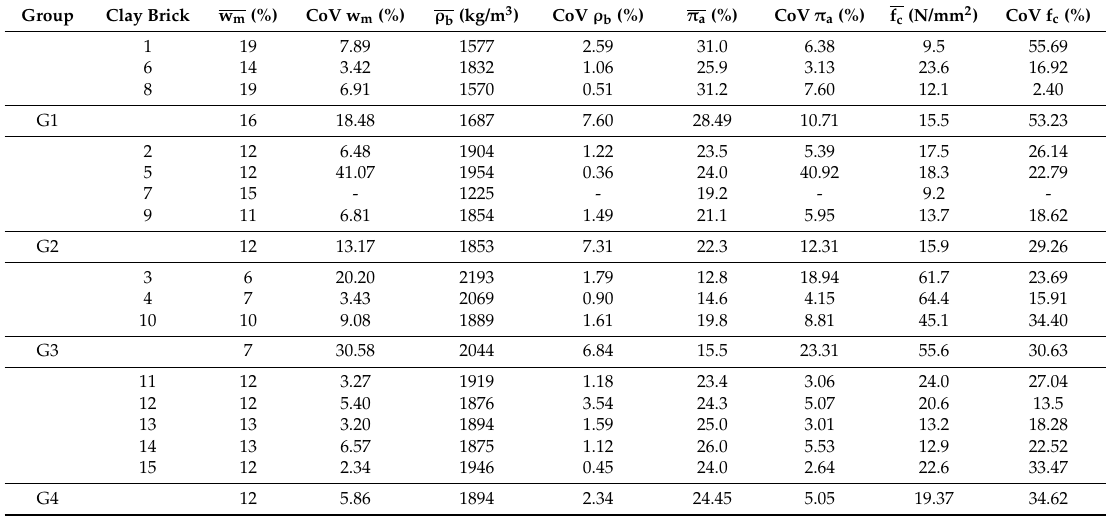
Table 2. Average values of the properties of the specimens from each clay brick and group. Group Clay